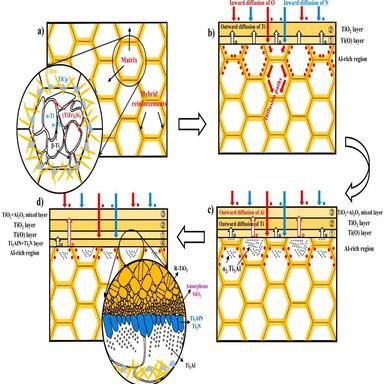
Schematic diagram of the oxidation mechanisms of the (TiC+TiB+(TiZr)5Si3)/TA15 composites after cyclic oxidation for 100 h.